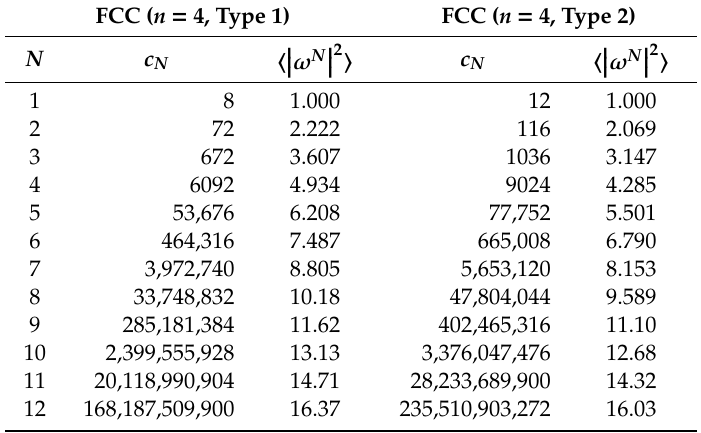
Table A11. Properties of SAWS on FCC lattice with 4 layers between the confining plates ( n = 4, Type 1,